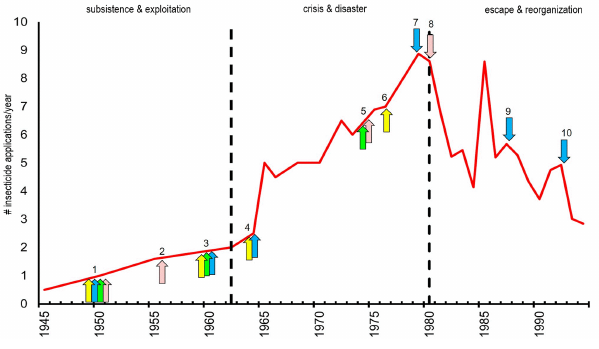
Fig. 2 . Time line representing enabling (upward arrows) and disabling (downward arrows) drivers of pesticide use in cotton production in Sudan from 1945 to 1995. The graph indicates the number of insecticide applications per year (Eveleens 1983, Bashir et al. 2003). Dashed lines indicate approximate times of the transition to a new phase of the treadmill. Colors referring to domains (I–IV) in the framework: (I) farming (yellow), (II) agro-landscapes (green), (III) science and technology (blue), and (IV) society (pink). Numbers and arrows indicate drivers of the treadmill; (1) pest outbreaks (yellow), cropping intensification (green), early season sprays (blue), centralized crop protection decision making (pink); (2) cotton export 71% of national export; (3) pesticide resistance and secondary pest resurgence (yellow), expansion of cotton growth area (green), pesticide mixtures and pesticides with different modes of action (blue); (4) secondary pest outbreaks (yellow), package deals (blue); (5) maximum cotton acreage (green), increasing crop protection costs (pink); (6) pesticide resistance to organophosphates; (7) start integrated pest management program; (8) ban on DDT and package deals; (9) development of biological control strategies, and large-scale demonstrations that fewer pesticides could be used; (10) economic threshold levels for four major cotton pest species were revised, improvement of the role of biological control agents in cotton crop protection, implementation of food crops in the cotton